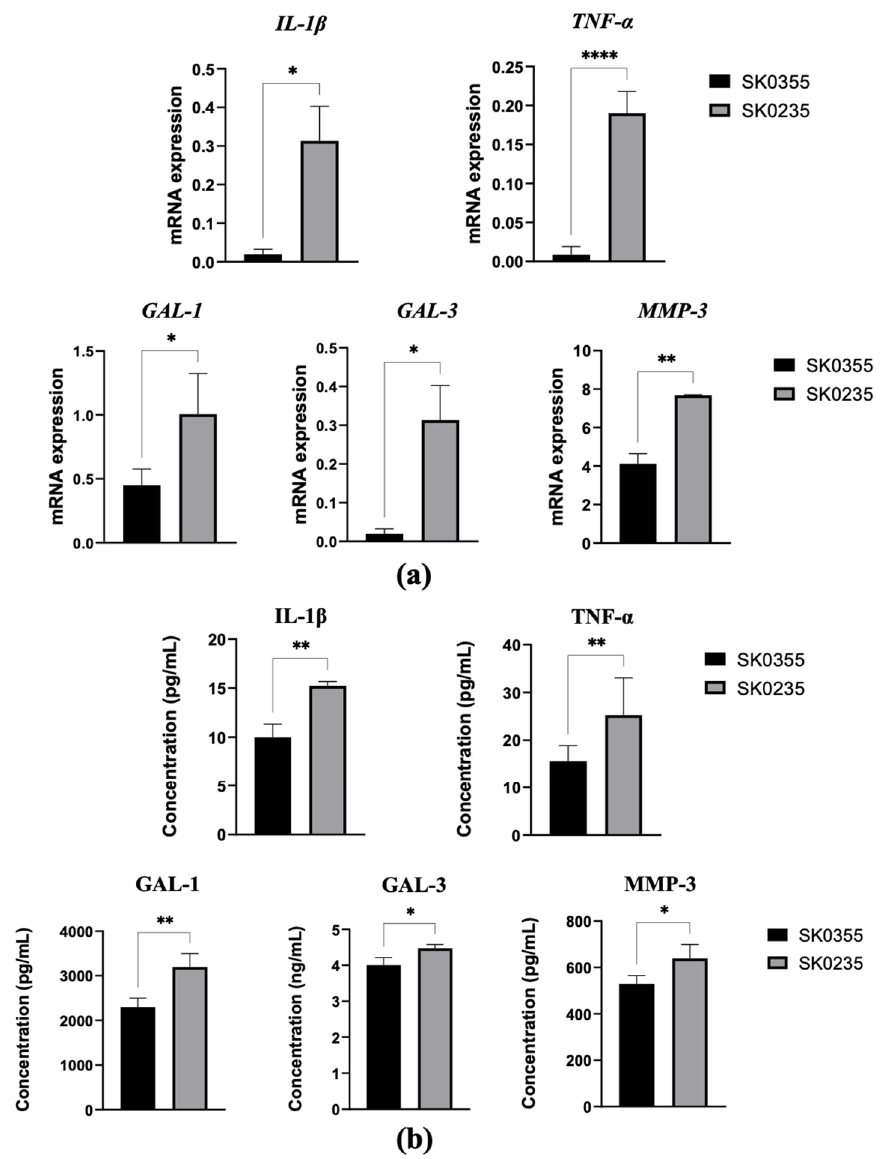
Figure 2. Dermal fibroblast expression of pro-inflammatory molecule, galectins and MMP-3. Human dermal fibro- blasts SK0355 (from a 30-year-old woman) and SK0235 (from a 54-year-old woman) were cultured and the expressions of pro-inflammatory molecule, galectins and MMP-3 were analysed. RNA tran- script levels ( a ) and protein expression ( b ) were evaluated by qPCR and ELISA test, respectively. Data are reported as mean ± standard error (SE) of three independent experiments. Statistical dif- ferences based on unpaired Student’s t-test. * p < 0.05 and ** p < 0.01 and **** p < 0.0001. Furthermore, SK0235 fibroblasts from the middle-aged donor down-regulated ECM molecules when compared to SK0355 fibroblasts from the younger woman (Figure 3, p < 0.05 for collagen type III and elastin; p < 0.01 for collagen type I).